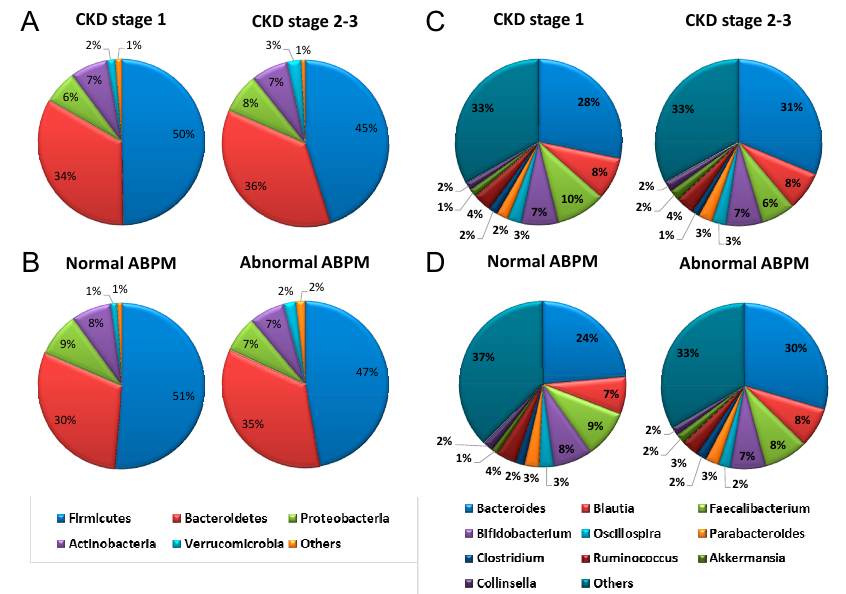
Figure 1. Relative abundances of top five phyla of gut microbiota in children with ( A ) CKD stage G1–G3 and ( B ) normal and ABPM profile. Relative abundances of top 10 genera of the gut microbiota in children with ( C ) CKD stage G1–G3 and ( D ) normal and abnormal ABPM